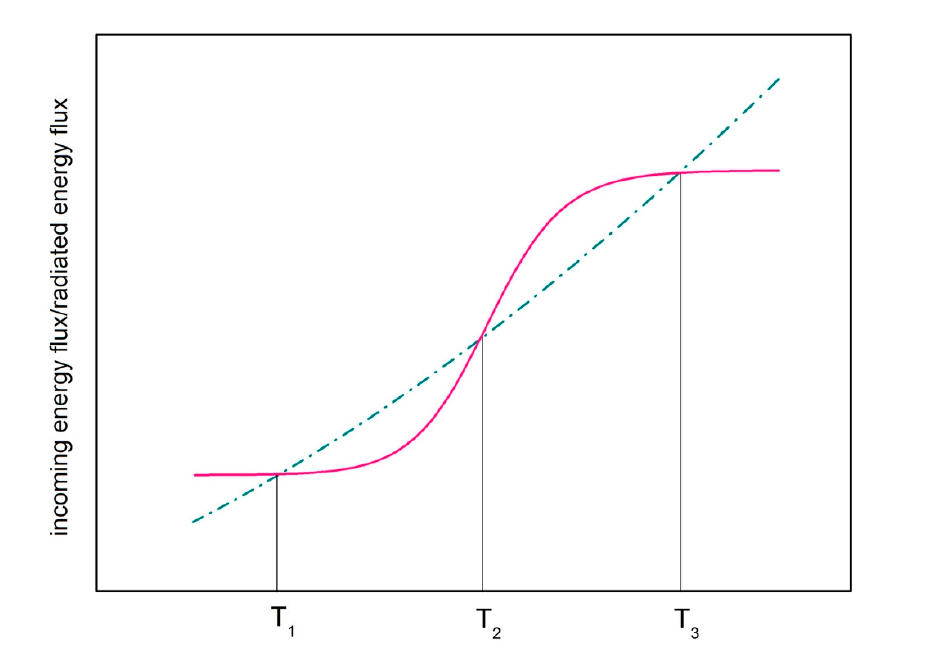
Figure 5. Sketch of incoming energy flux (continuous pink line) and radiated energy flux (dotted-dashed green line) as a function of the average planet temperature for the energy balance model. The intersections between the two curves identify the system stationary configurations, of which T 1 and T 3 are stable, while T 2 is unstable.